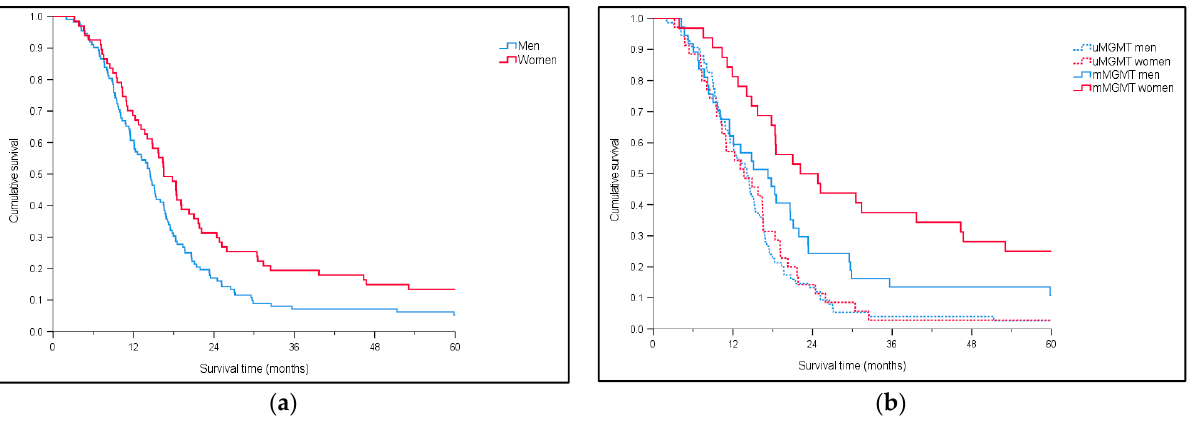
Figure 2. Overall survival in the population-based cohort ( a ) for men ( n = 112) vs. women ( n = 67) ( p = 0.035). ( b ) For men ( uMGMT = 75; mMGMT = 37) vs. women ( uMGMT = 35; mMGMT = 32) according to MGMT status ( p = 0.0002).